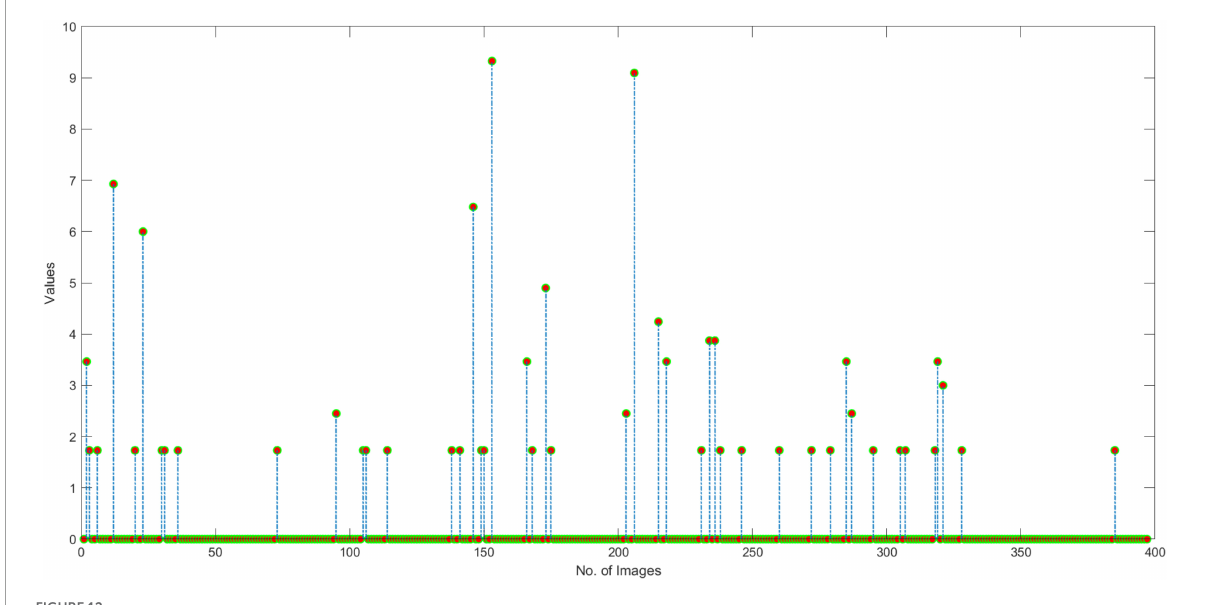
FIGURE12 Similarity with AHB class.